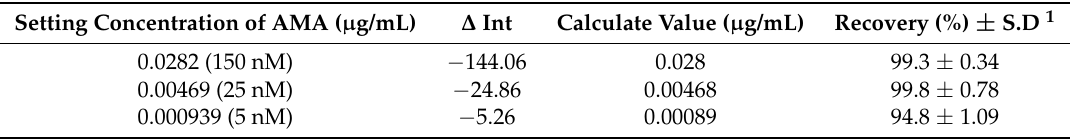
Table 2. Detecting result of simulative